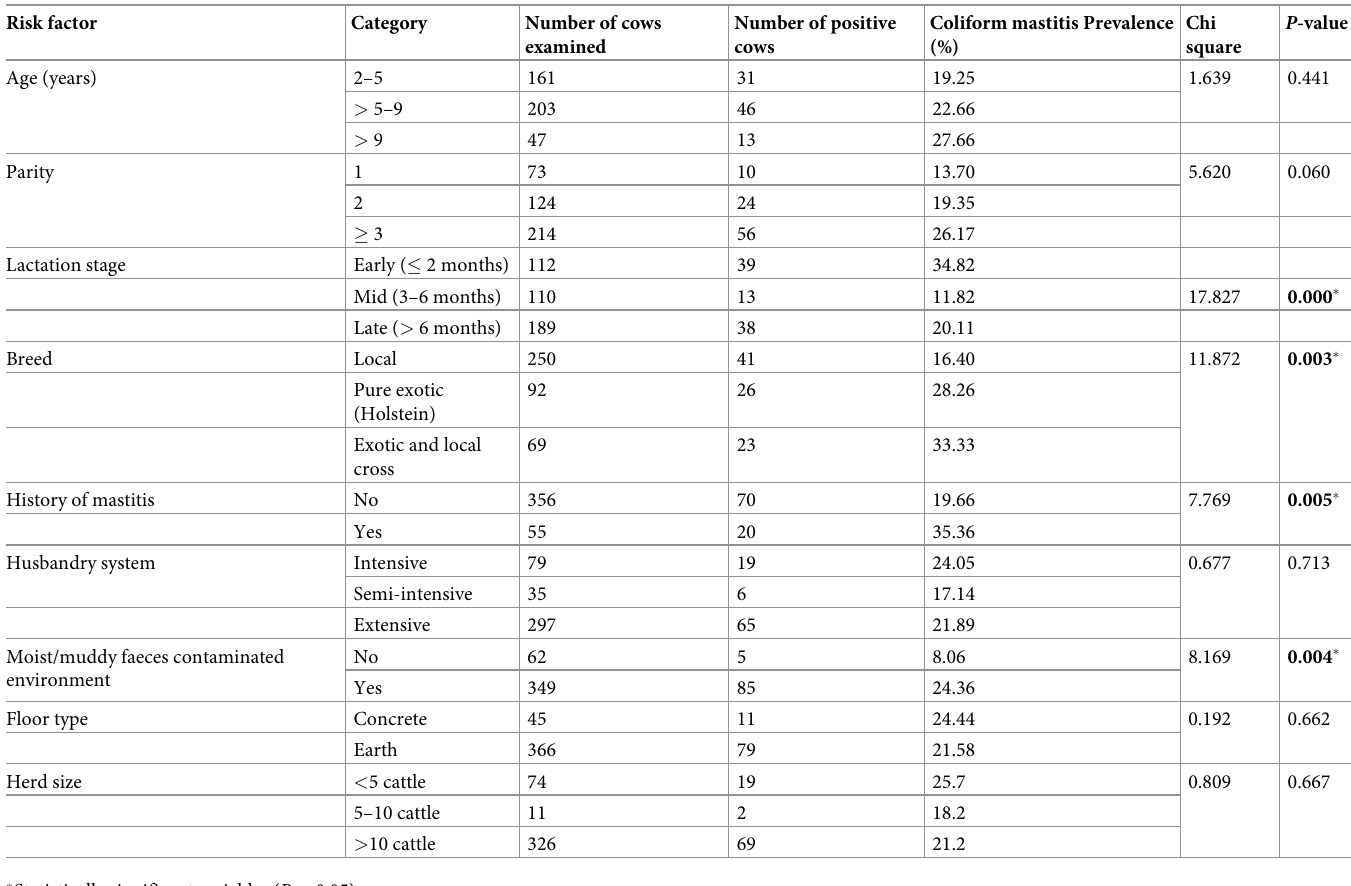
Table 5. Risk factors associated with the prevalence of coliform mastitis.